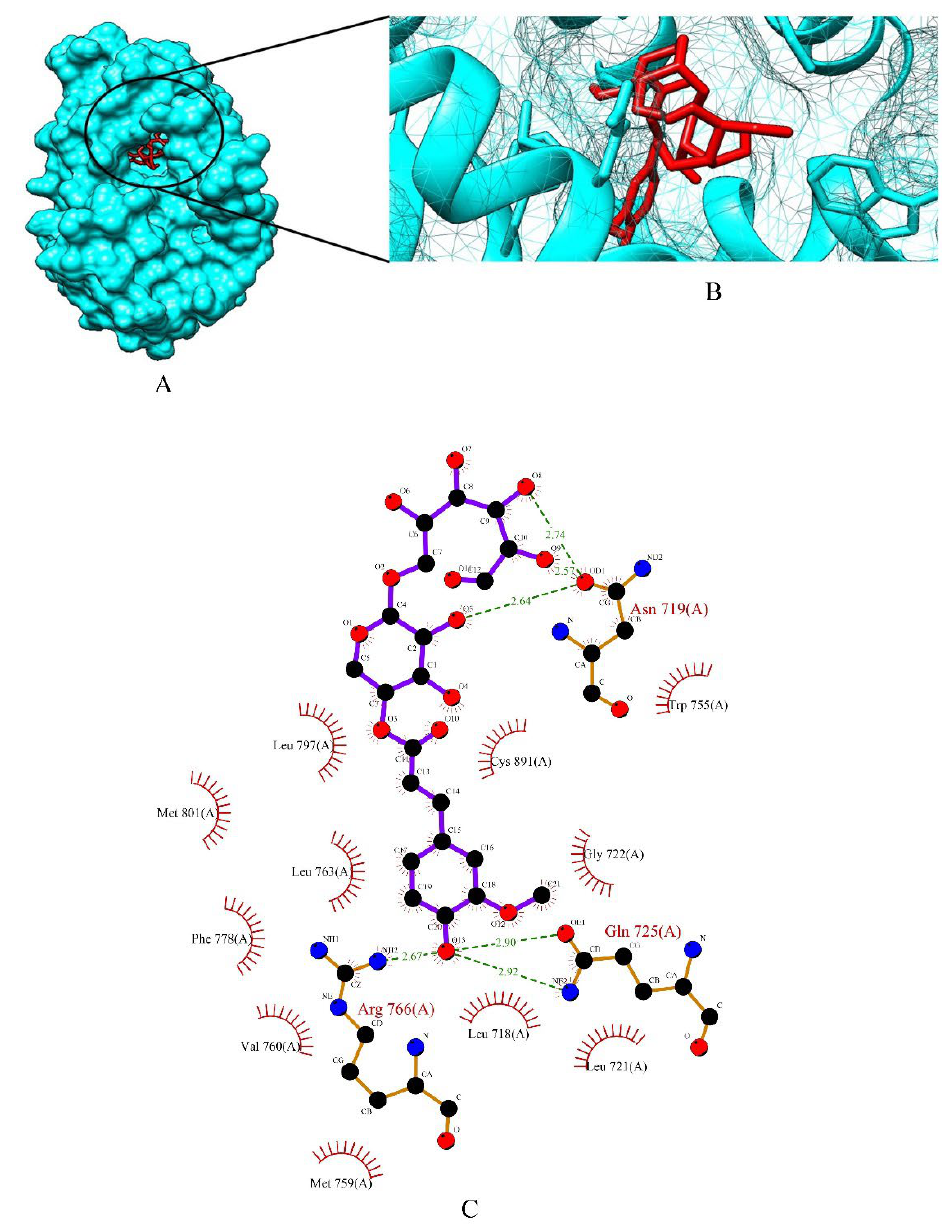
Figure 8. ( A ) Surface view of xyloglucan-PR binding complex. ( B ) Binding pose of xyloglucan. ( C ) Visualization of the docked complex with ligplot + shows the binding interaction of xyloglucan with PR. Six hydrogen bond interactions (green dotted lines) were formed between xyloglucan and three amino acid residues (Asn 719, Gln 725, Arg 766) of target protein PR.